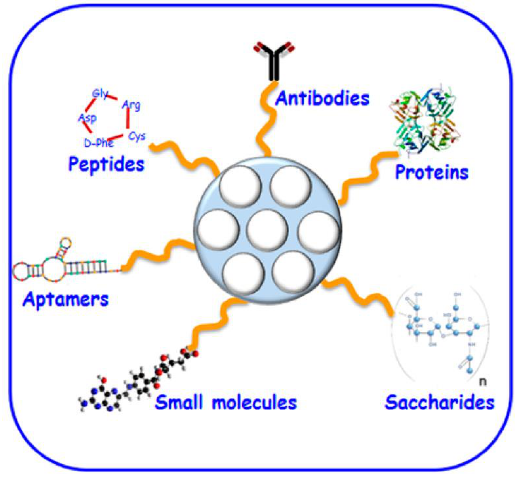
Figure 7. The possibilities of attaching (macro)molecules on the surface of MSN for active targeting. Reprinted from an open access source